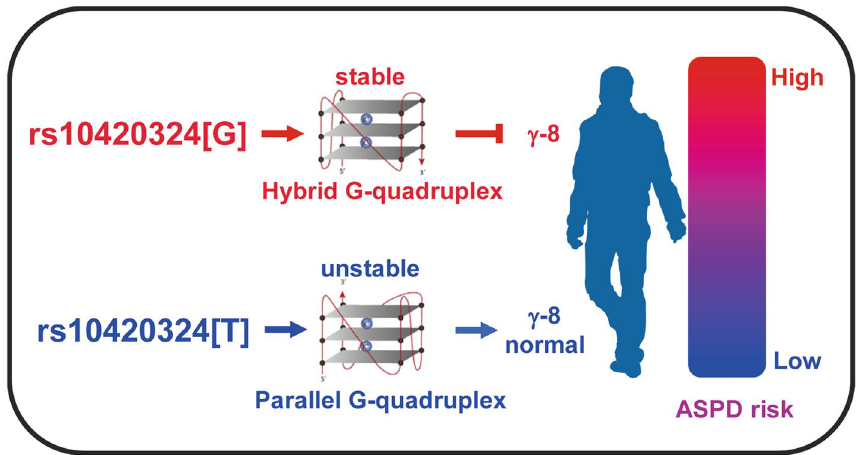
Figure 6. A model illustrating a molecular mechanism that rs10420324 in CACNG8 regulates the susceptibility to ASPD. The SNP site rs10420324 (T/G) in the 1st intron of CACNG8 determined TARP γ-8 expression by regulating the conformation (parallel/hybrid) and stability of a local G-quadruplex. The rs10420324G suppresses TARP γ-8 expression, thus increases ASPD